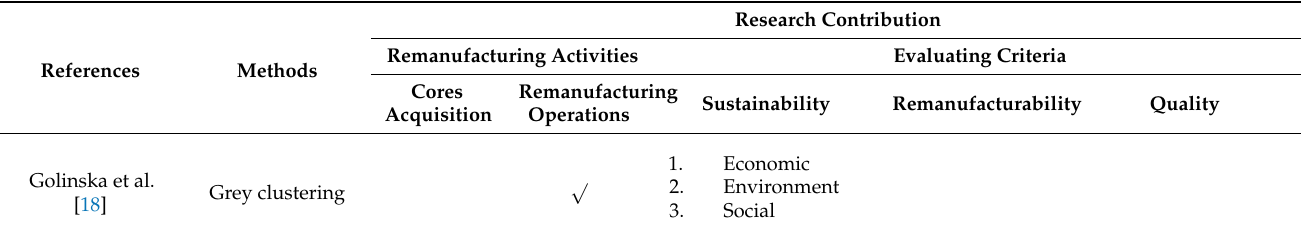
Table 3. Comparison of previous works with the proposed models. AHP: analytical hierarchy